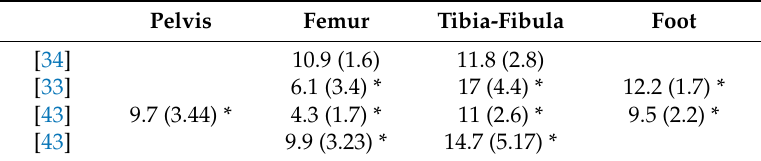
Table 4. Residual angle computation characterizing the di ff erence between the calibration matrices obtained with the calibration method and the method of reference, the Mean (standard error), in degrees, for each segment coordinate system.